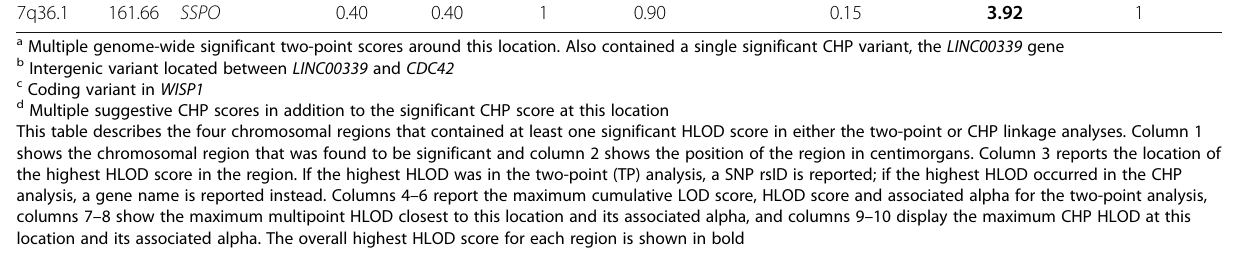
Max LOD Max HLOD Alpha for or Gene (CHP) Score Score HLOD